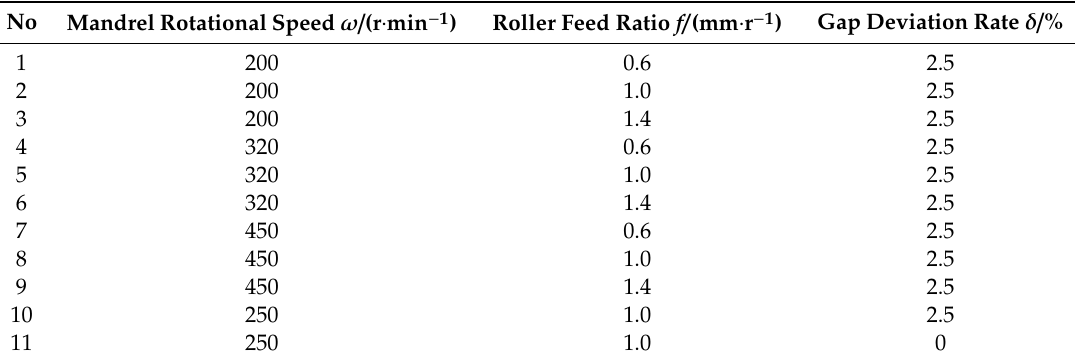
Table 3. The single factor variable test